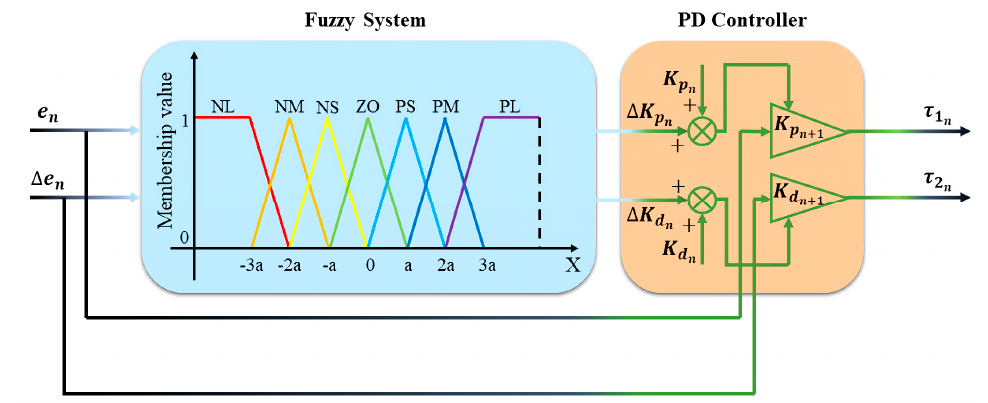
Figure 4. Fuzzy PD system of the neural feedback controller, which aims to generate the torques for driving the arm to the target position.